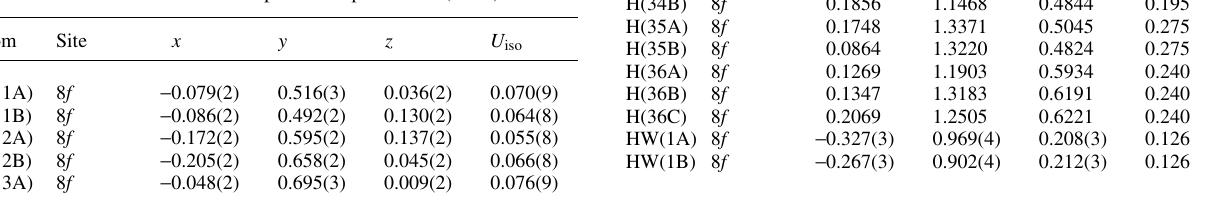
Table 2. Atomic coordinates and displacement parameters (in Å 2 ) .